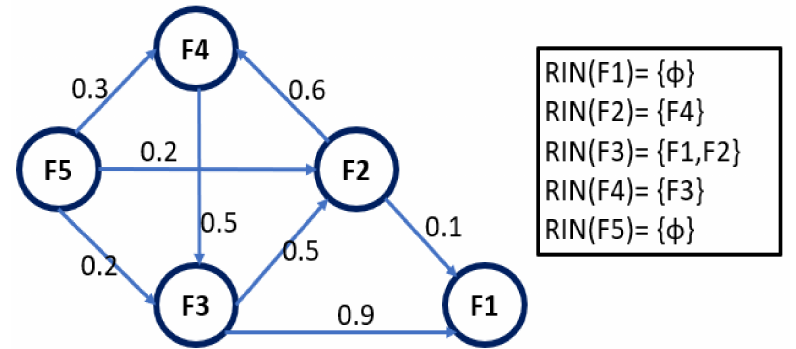
Figure 3. Example of a reverse set of influential